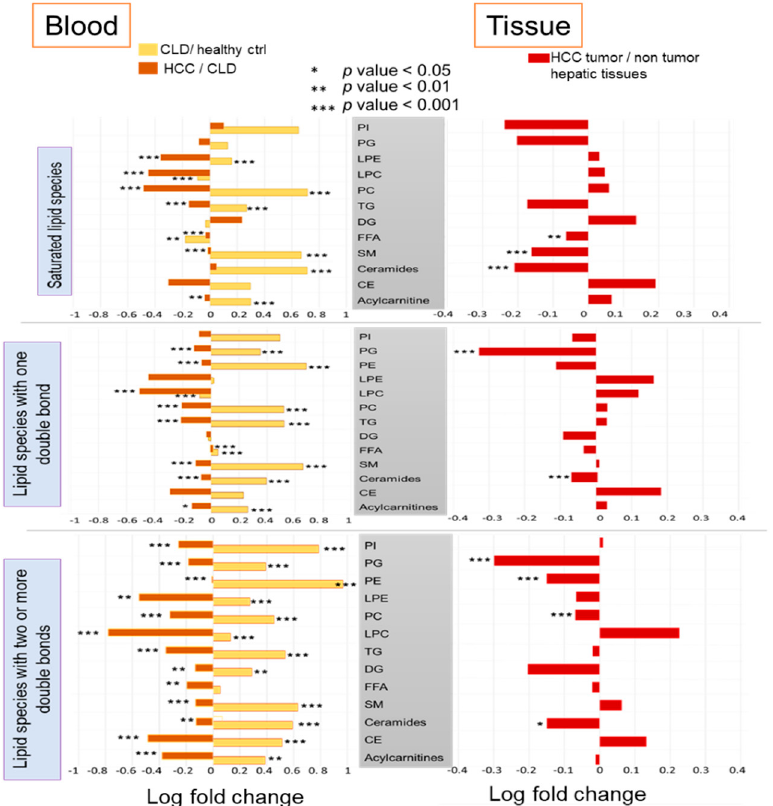
Figure 6. Differential lipid set enrichment statistics according to the level of desaturation in fatty acyl groups for each lipid class. Left panel: blood lipids. Right panel: HCC tumor lipids versus paired nontumor hepatic tissues.